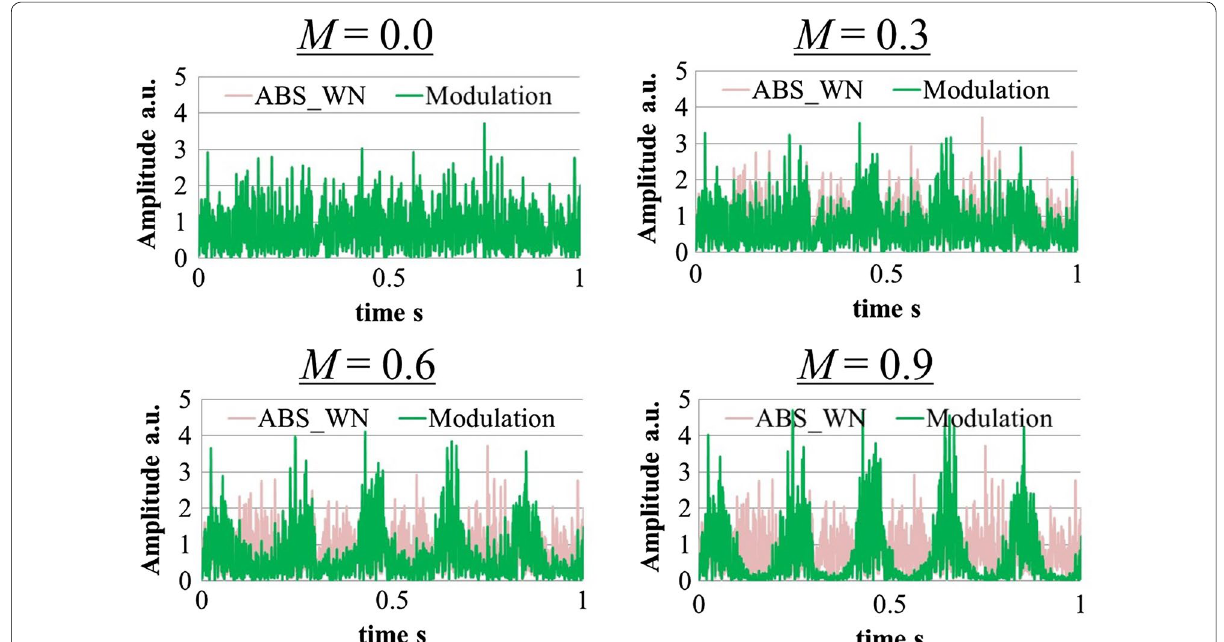
Fig. 8 Effects of the variation of the modulation strength N D by the variation of the modulation depth M . The light flesh-coloured line shows the rectified white noise, and the deep green line shows the modulated signal with the modulation strength N